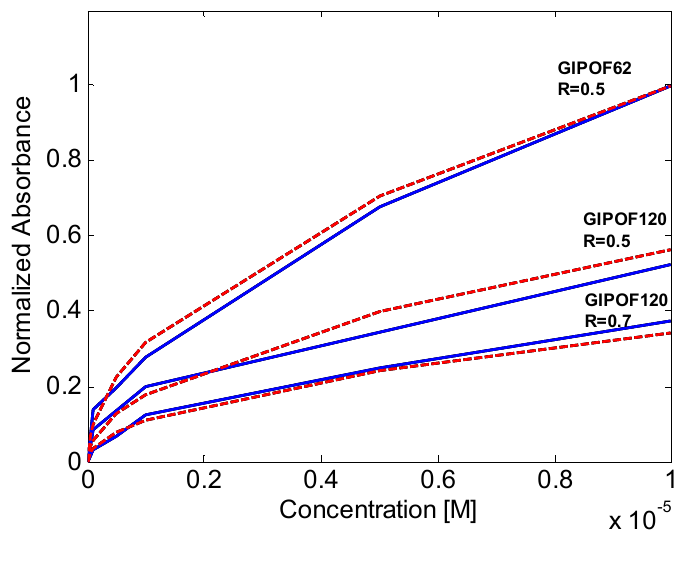
Figure 8. Normalized absorbance verus methylene blue. Experimental results (solid line). Theoretical model (dashed